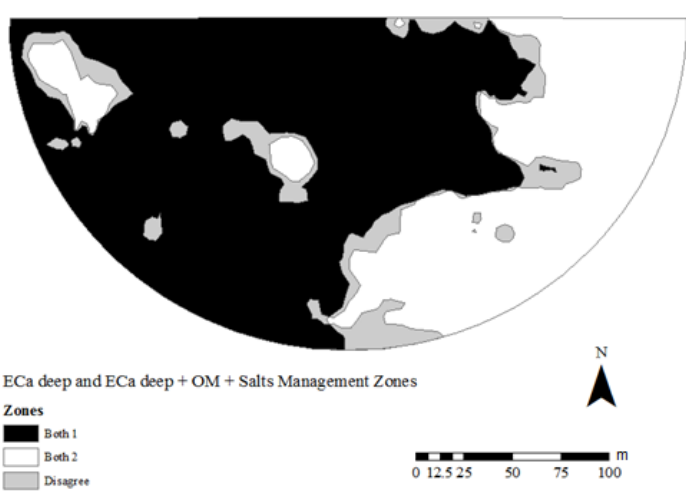
Figure 3. Comparison of management zones delineated with using soil ECa measured up to 1.5 m depth and management zones delineated using soil ECa measured up to 1.5 m depth in addition to organic matter and soil salinity for ARDEC. Differences in the two techniques are presented as gray color referred to as “disagree” in the legend.